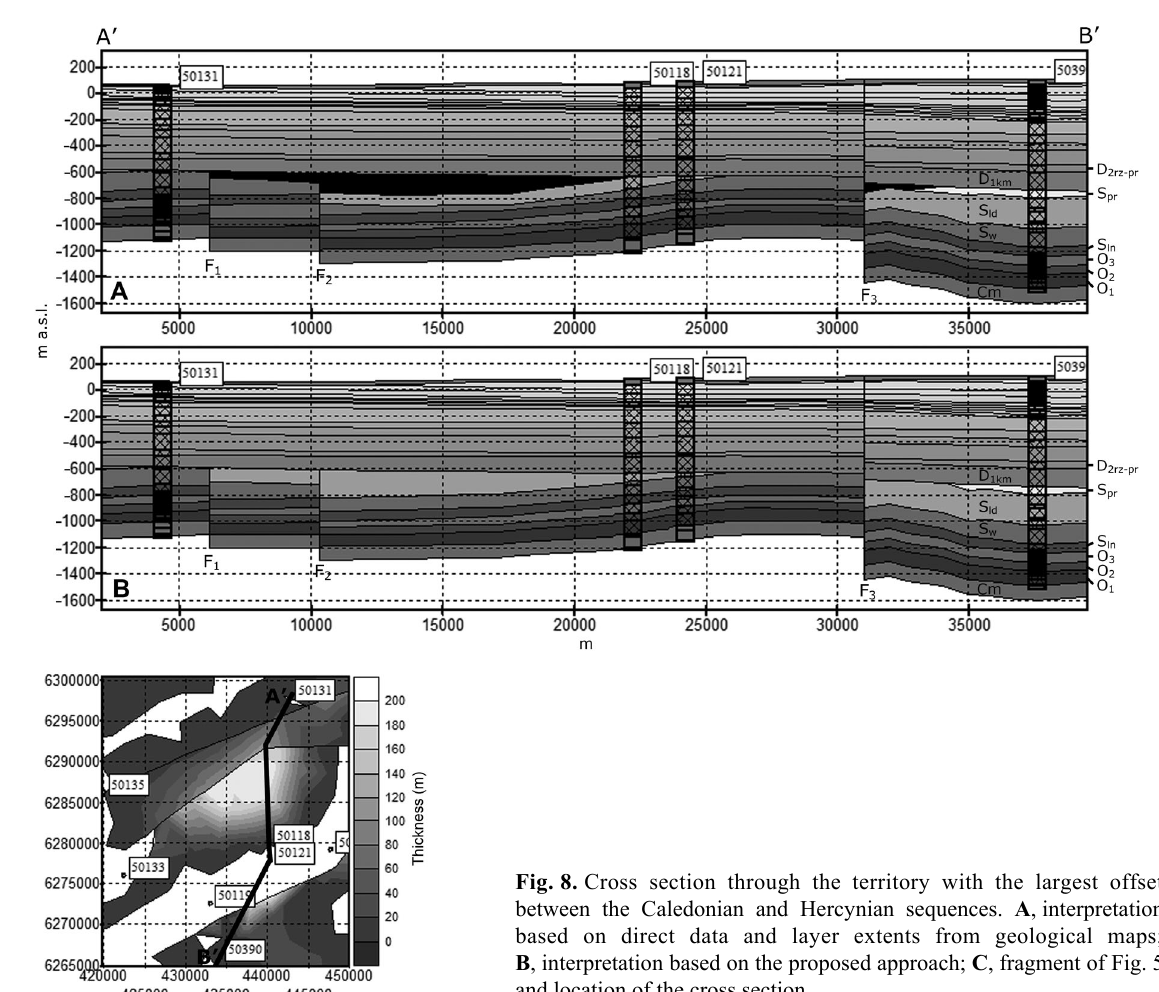
Fig. 8. Cross section through the territory with the largest offset between the Caledonian and Hercynian sequences. A , interpretation based on direct data and layer extents from geological maps; B , interpretation based on the proposed approach; C , fragment of Fig. 5 and location of the cross